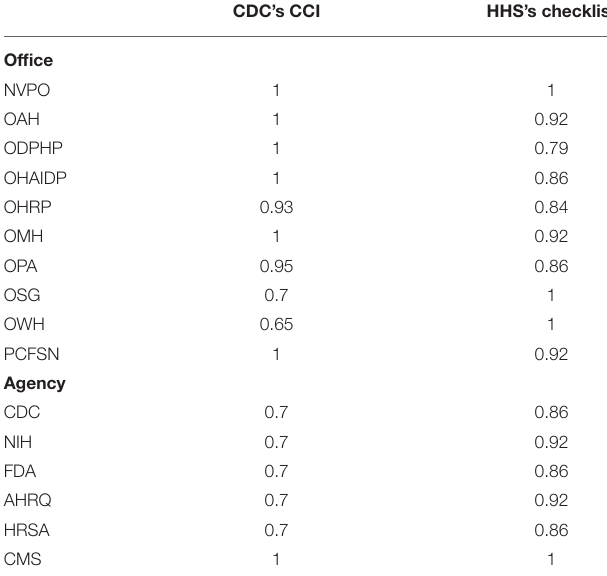
TABLE 8 | Home page